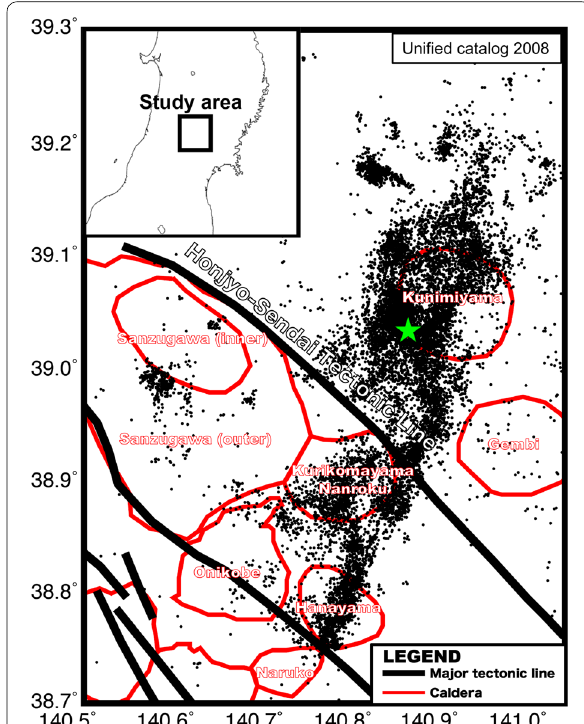
Fig. 1 Distribution of calderas, tectonic lines, and earthquakes in the study area. Calderas and tectonic lines are from Nunohara et al. (2010) and Baba (2017), respectively. Epicenters of earthquakes in 2008 at depths 15 km are shown as black dots and are from the JMA unified ≤ catalog. The green star denotes the mainshock epicenter estimated by Okada et al.